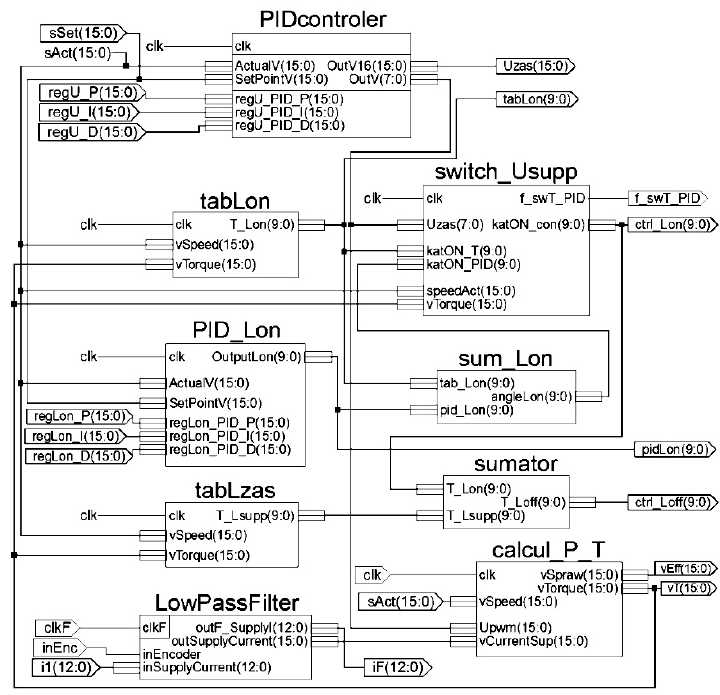
Figure 11. Block diagram of the proposed regulator implemented in the FPGA device.